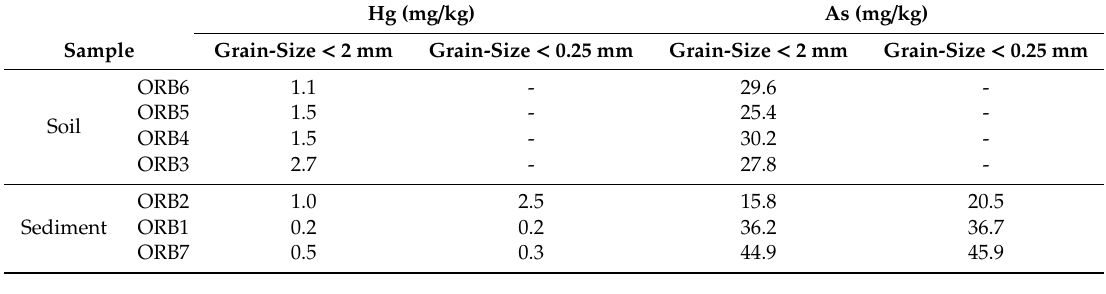
Table 4. Concentrations in mg / kg of Hg and As analyzed on two grain-size fractions.